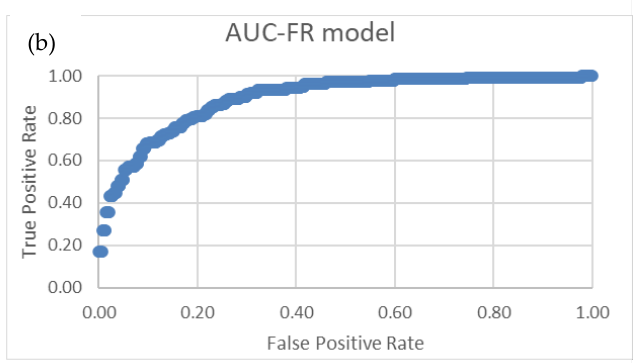
Water 2023 , 15 , x FOR PEER REVIEW Figure 9. ( a ) GWPZ areas of predicted model; ( b ) AUCs of predicted GWPZ. Figure 9. ( a ) GWPZ areas of predicted model; ( b ) AUCs of predicted GWPZ.